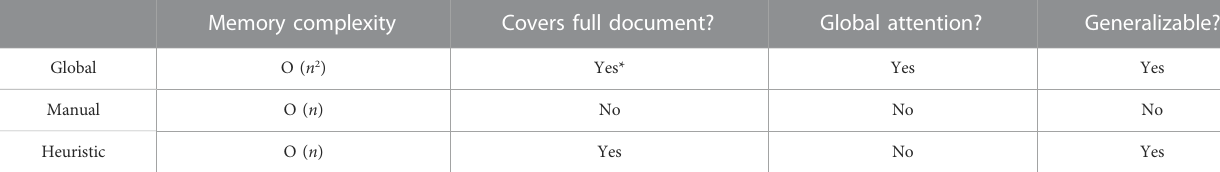
TABLE 2 Comparison of training variants. *: When enough memory is